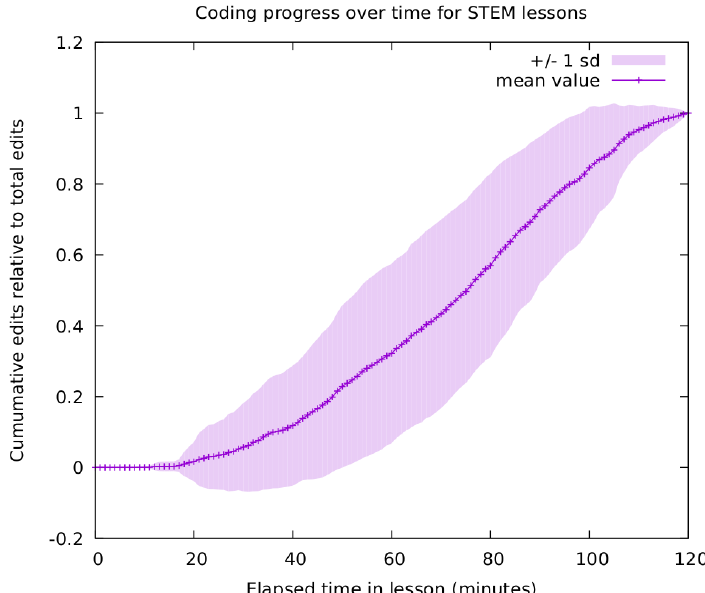
Fig. 5. Cumulative edits made in the lessons against time for all students in non-STEAM les- sons. The number of edits is normalised against the total number of edits.